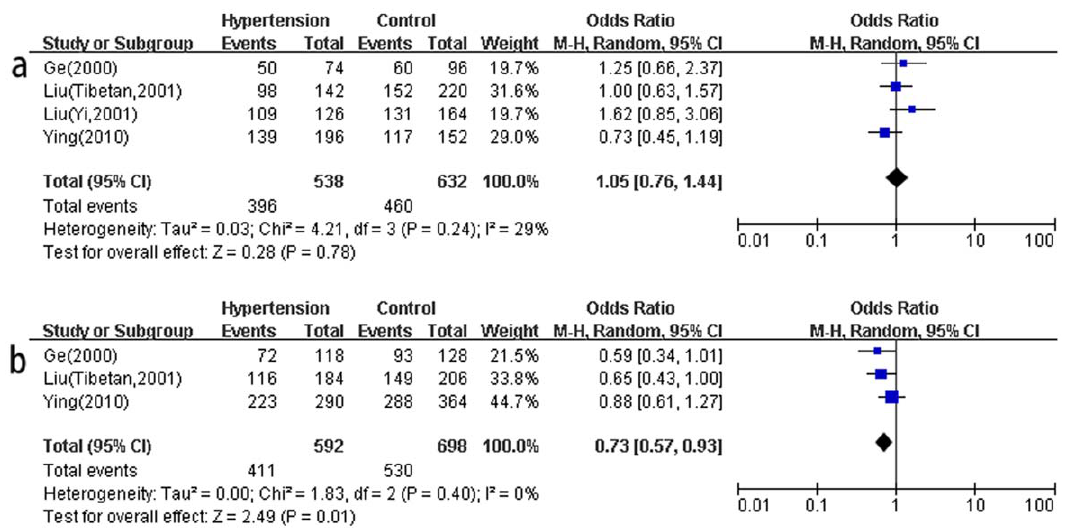
Figure 3. Meta-analysis for the association between the A-6G polymorphism and hypertension under allele comparison (A vs. G) in the subgroup by sex. Figure 3a shows that the A-6G polymorphism is not associated with hypertension in men. Figure 3b shows that the -6 A allele carrier can reduce the risk of hypertension in women compared to the -6G allele carrier.